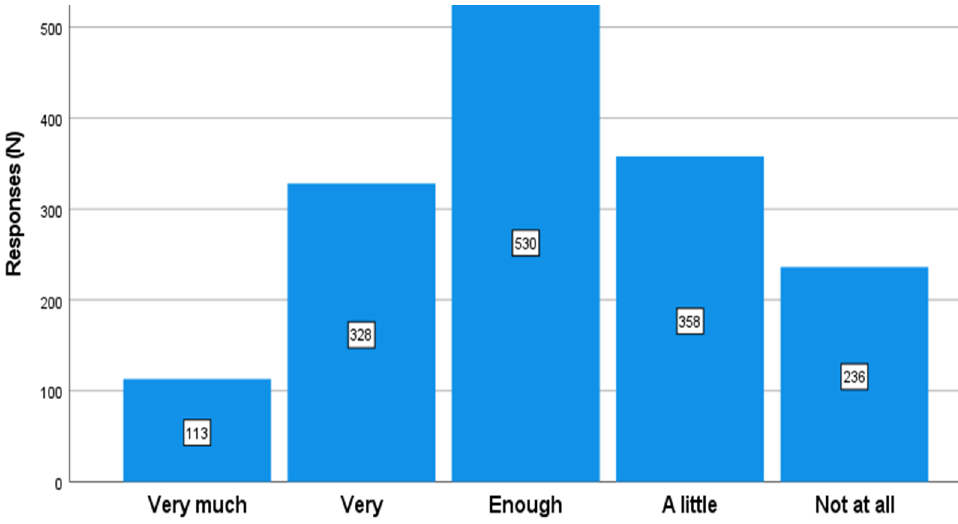
Figure 2. Responses to the question, “How informed do you think you are about circular economy?”